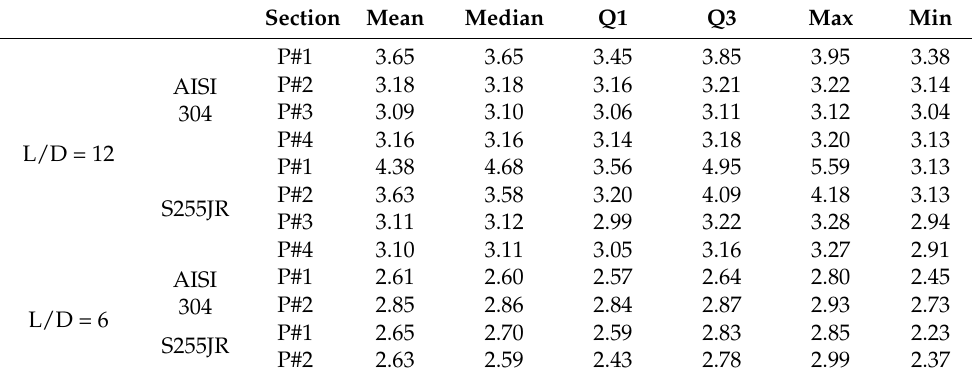
Table 4. Main statistics of the arithmetical mean height (Ra)